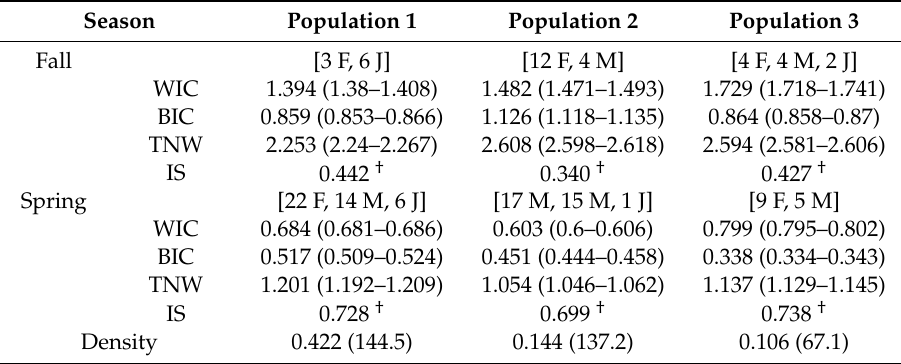
Table 3. Summary of trophic niche metrics and number of analysed individuals per season (in square brackets) of the three Hydromantes ambrosii populations. WIC = within-individual component; BIC = between-individual component; TNW = total niche width; IS = individual specialisation. 95% bootstrapped confidence intervals are in round brackets. The estimated density (N individuals / m 2 ) and, within parentheses, the total population size estimated by Ficetola et al. [48] of each population are included. † p >